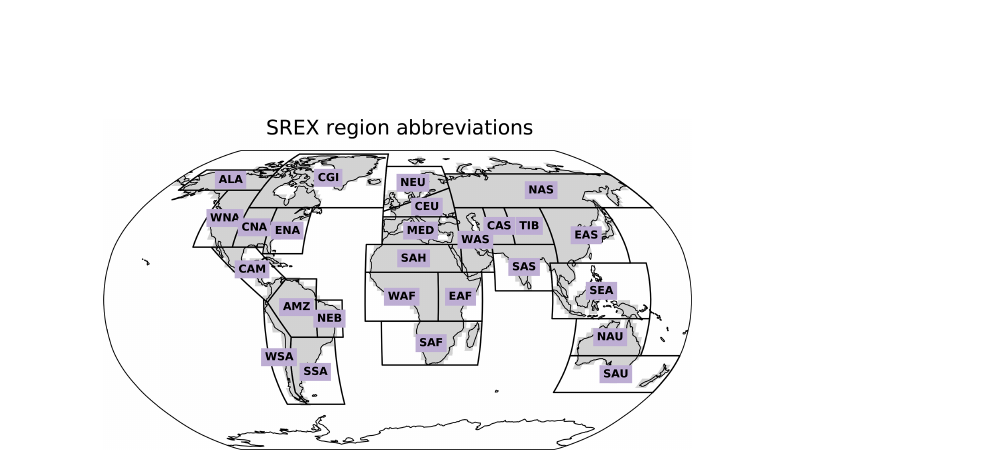
Figure D1. Map of the SREX regions and their abbreviations. The considered land grid points are shown in grey.